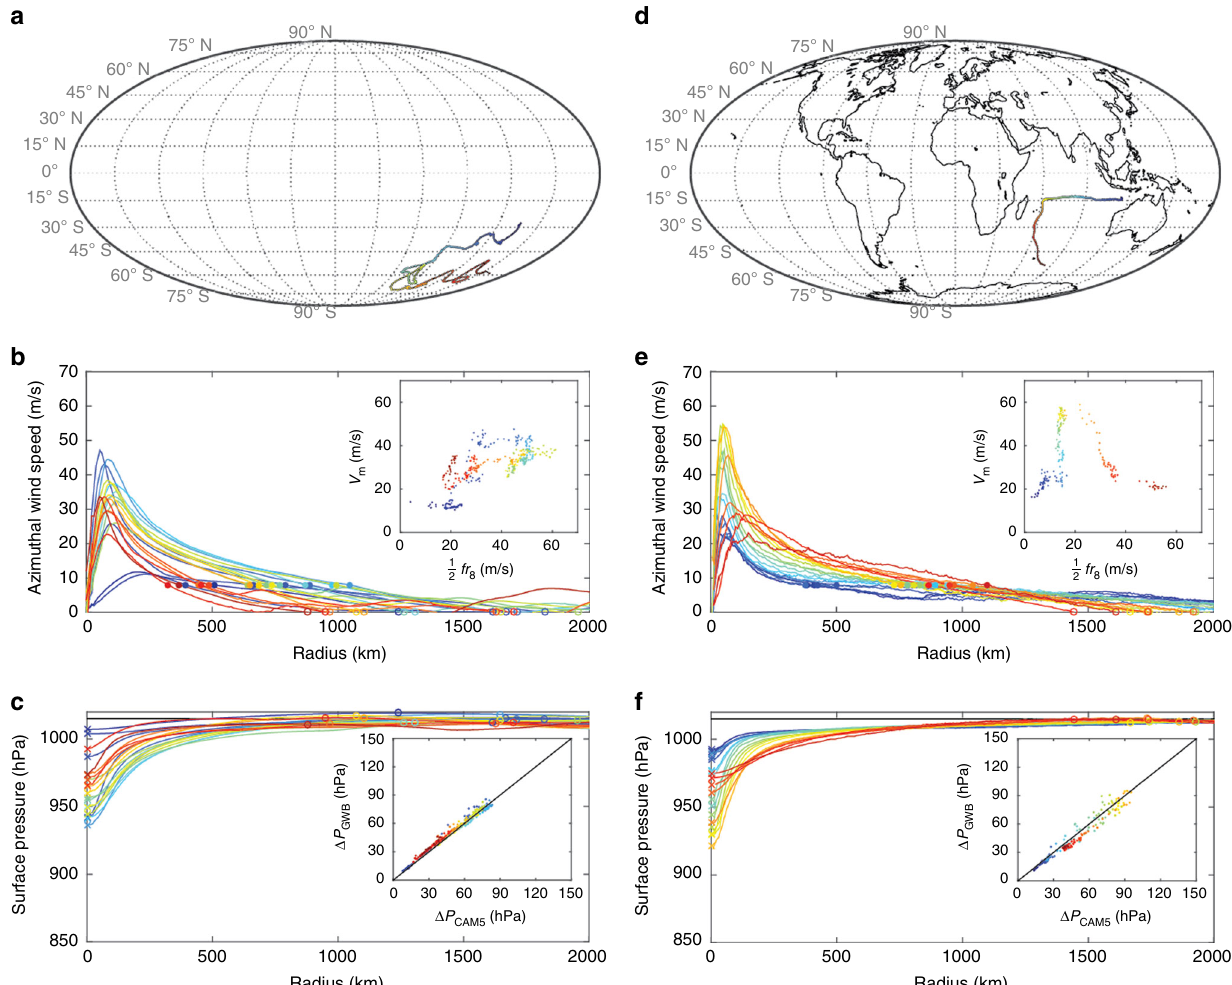
Fig. 3 Example tracks and gradient wind balance calculations from OMEGA and AMIP simulations. a Track map for OMEGA. b Evolution of azimuthal- fr fi les and (inset) comparison mean near-surface azimuthal wind pro fi le and (inset) value of ( V m , 1 8 ) for OMEGA. c Azimuthal-mean surface pressure pro 2 of CAM5 central pressure de fi cit, Δ P CAM5 , against gradient wind balance prediction, Δ P GWB for OMEGA. d – f Same as a – c for AMIP track. Time increases from blue to green to red. Twenty pro fi les are plotted in even steps spanning the life-cycle; insets show all time steps. Filled circles denote r 8 ; open circles denote r 0 and P 0 ; crosses denotes minimum central